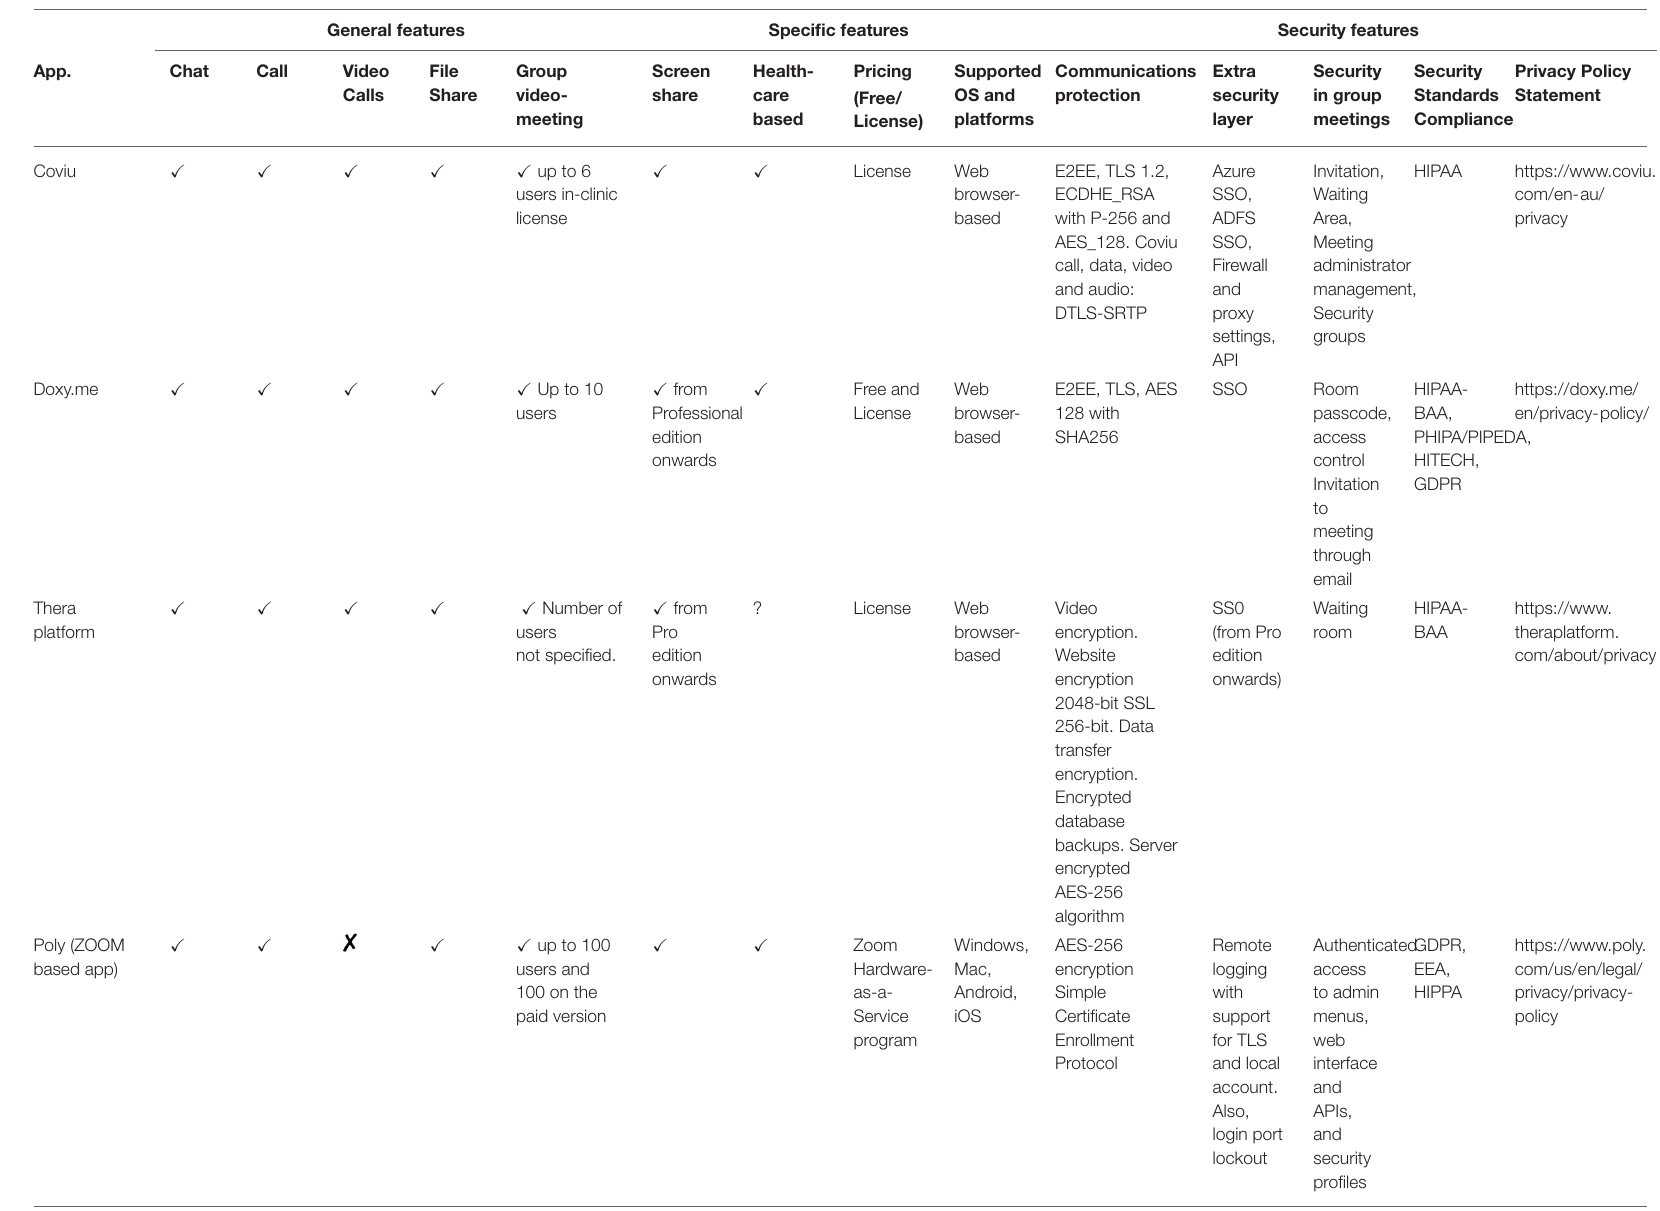
TABLE 2 | Specific healthcare based